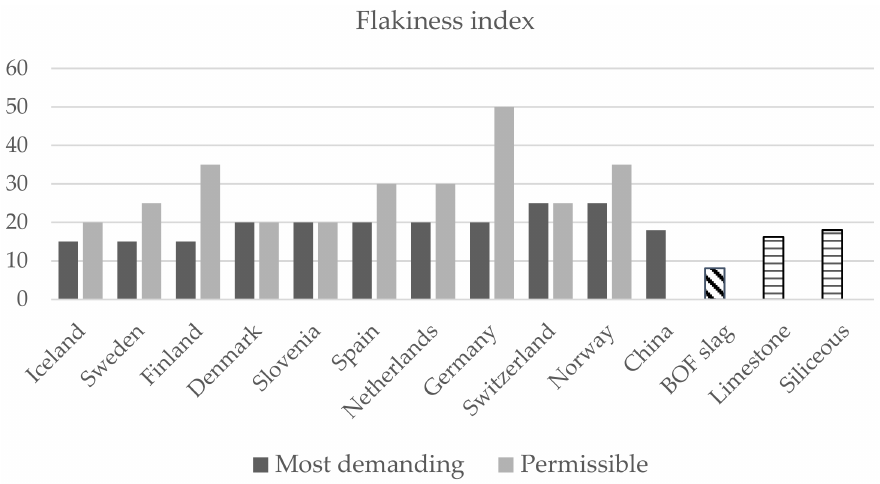
Figure 4. International comparison requirements for aggregates in road construction: Flakiness